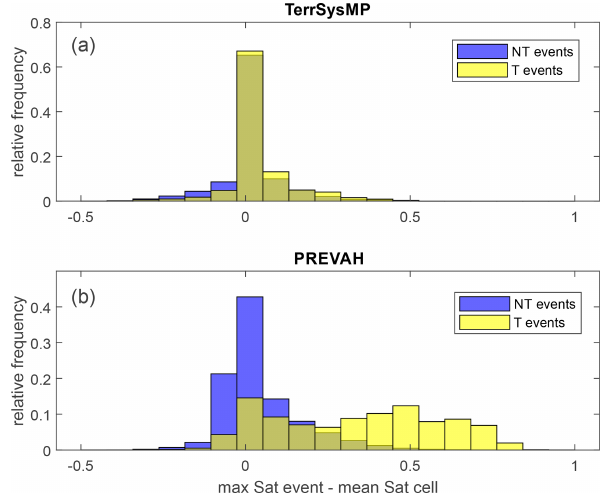
Figure 5. Histograms of the departure of the maximum event satu- ration from its long-term local temporal mean for landslide trigger- ing and non-triggering events, considering (a) saturation estimates from TerrSysMP and (b) from